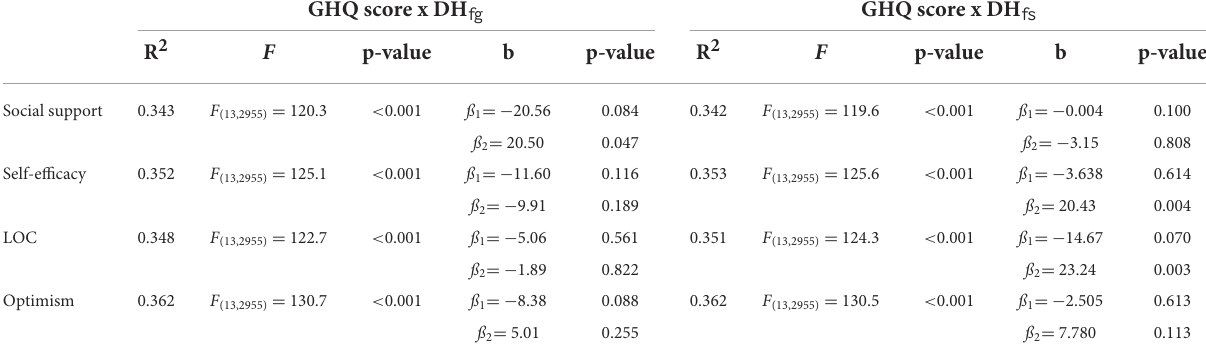
TABLE 3 Moderation analysis—protective factors (controlling for DH fs or DH fg , age, gender, education, somatic illness, and mental